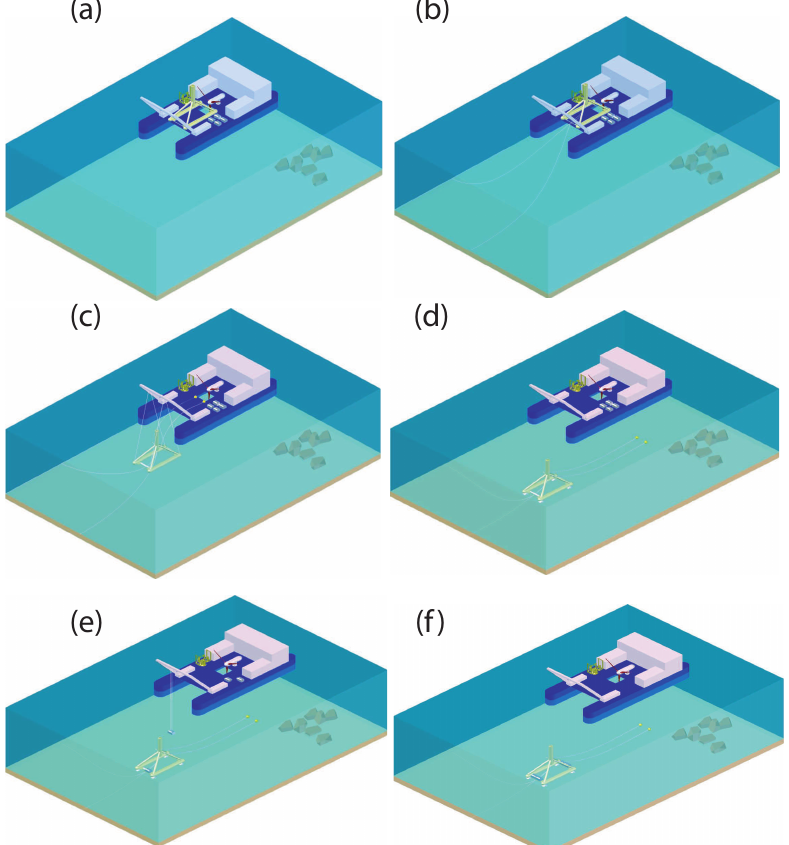
Figure 4. Installation of the structure of the TECs: ( a ) position required to install the base; ( b ) connection of the umbilical cables to the TEC structure; ( c ) controlled descent of the TEC structure; ( d ) fixing the TEC structure to the seabed; ( e ) placement of the concrete ballasts; and ( f ) installation of the TEC structure once the process has been